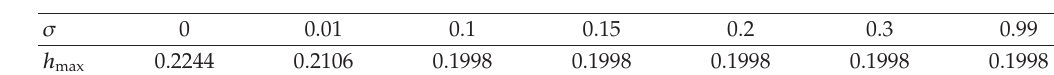
Table 2: τ (cid:8) 1, d (cid:8) 0 .